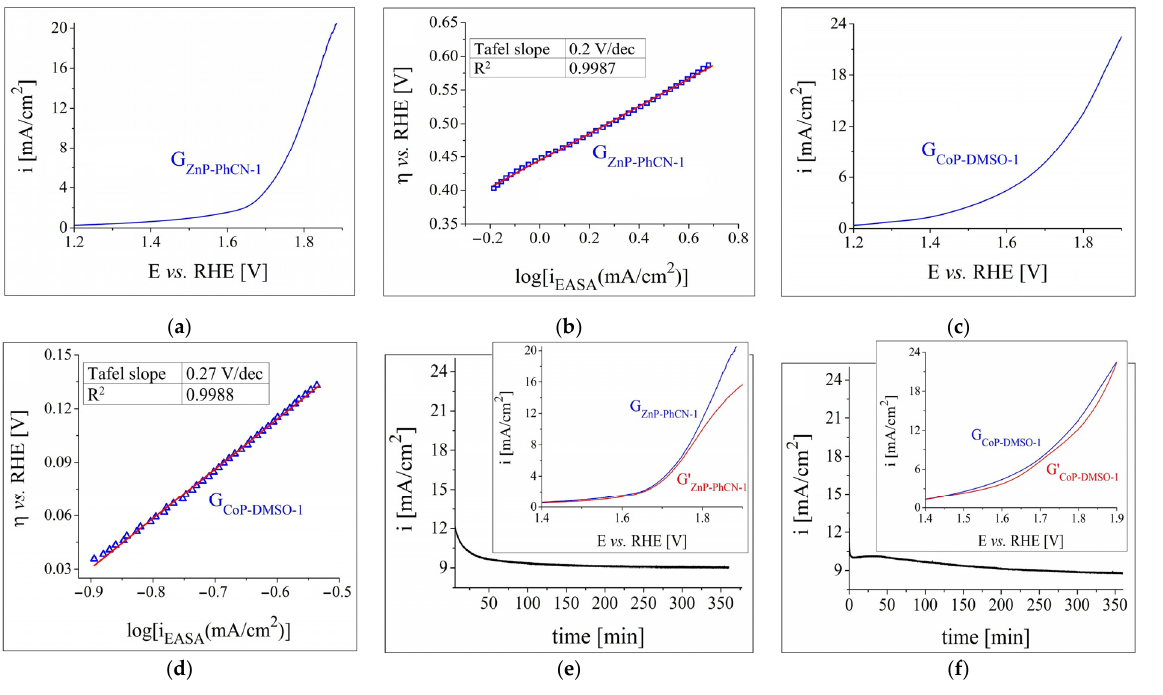
Figure 6. ( a ) Anodic polarisation curve recorded in 1 M KOH electrolyte solution on the G ZnP ‐ PhCN ‐ 1 electrode at v = 1 mV/s. ( b ) The Tafel plot for the G ZnP ‐ PhCN ‐ 1 sample in 1 M KOH solution. ( c ) Anodic polarisation curve traced in 0.5 M H 2 SO 4 electrolyte solution on the G CoP ‐ DMSO ‐ 1 electrode. ( d ) The Tafel plot for the G CoP ‐ DMSO ‐ 1 sample in 0.5 M H 2 SO 4 solution. ( e ) The i–time curve recorded on the G ZnP ‐ PhCN ‐ 1 electrode in 1 M NaOH solution and inset with the LSVs obtained on the same specimen, before (G ZnP ‐ PhCN ‐ 1 ) and after (G ′ ZnP ‐ PhCN ‐ 1 ) the stability test. ( f ) The i–time curve recorded on the G CoP ‐ DMSO ‐ 1 electrode in 0.5 M H 2 SO 4 solution and inset with the voltammograms traced on the same specimen, before (G CoP ‐ DMSO ‐ 1 ) and after (G ′ CoP ‐ DMSO ‐ 1 ) the stability test.